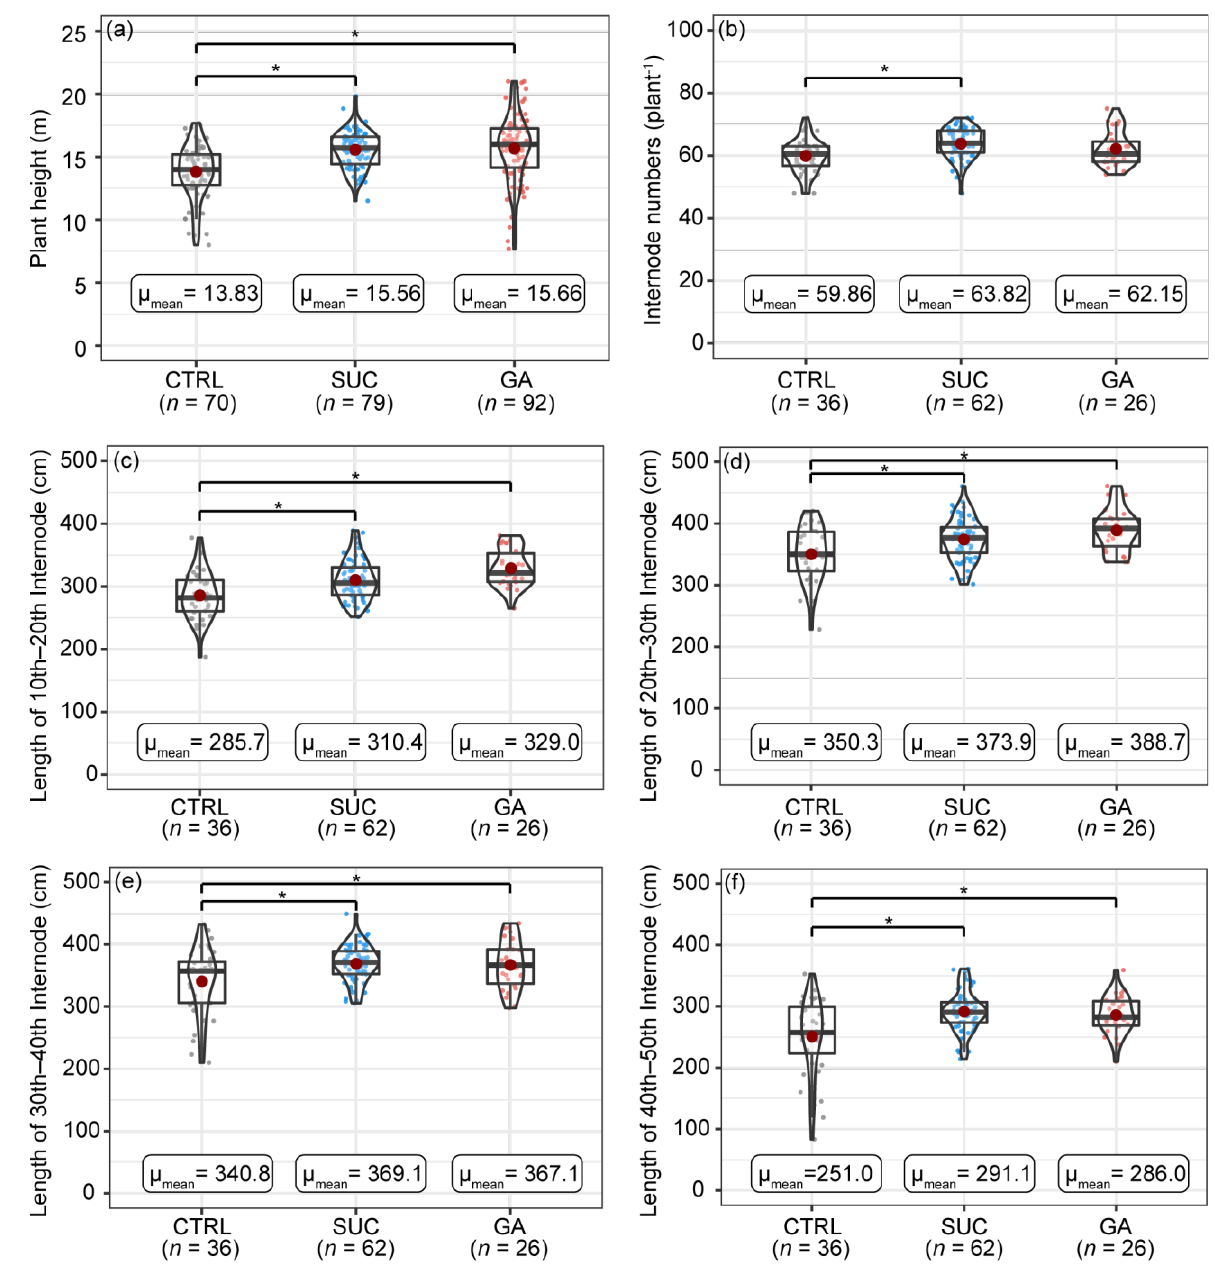
Figure 1. Comparisons of the plant height ( a ), internode number ( b ), lengths of the 10th–20th internodes ( c ), lengths of the 20th–30th internodes ( d ), lengths of the 30th–40th internodes ( e ), and lengths of the 40th–50th internodes ( f ) under different exogenous treatments. Box plots and violin plots show the data distribution of each variable. Points represent the measured values of each variable. Red points indicate mean values. The numbers in brackets represent sampling numbers. An asterisk means a significant difference according to the Bayesian GLMM.